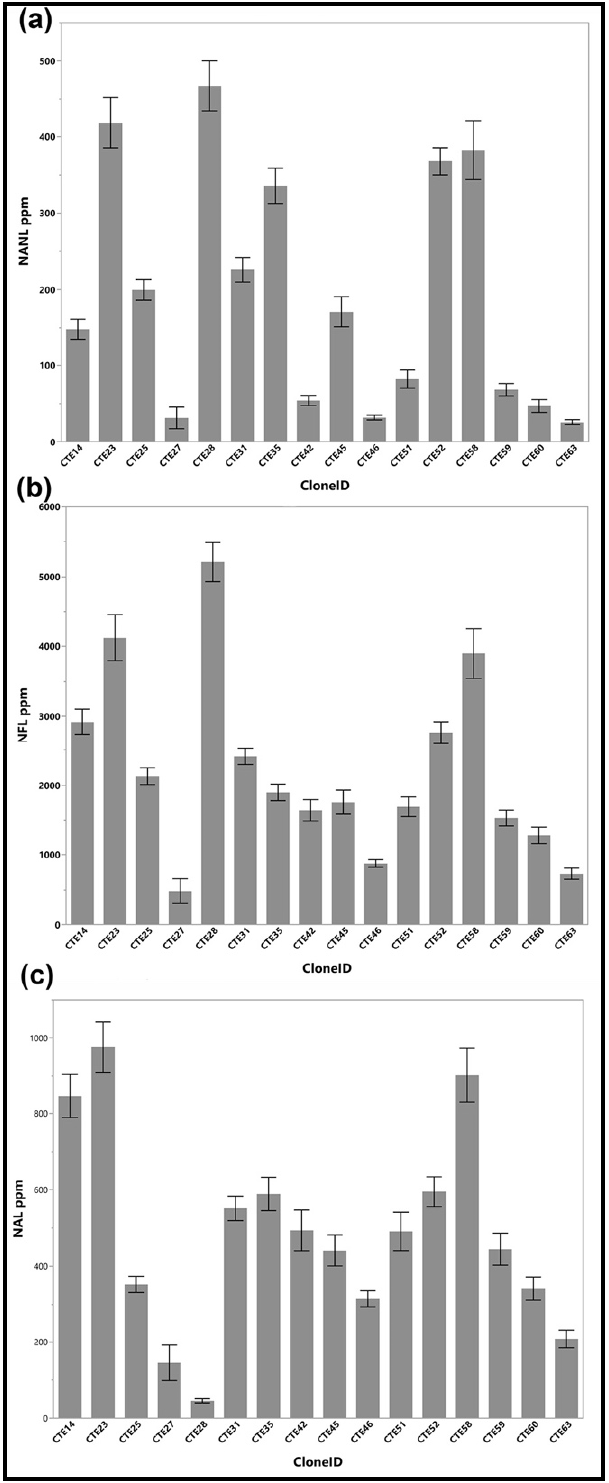
Figure 4. Average accumulation of the different lolines ( a ) N-acetylnorloline (NANL), ( b ) N-formal loline (NFL), and ( c ) N-acetylloline (NAL) in seed heads of 16 CTE tall fescue clones from 2017 to 2019. Data are means +/ − 1 s.e.